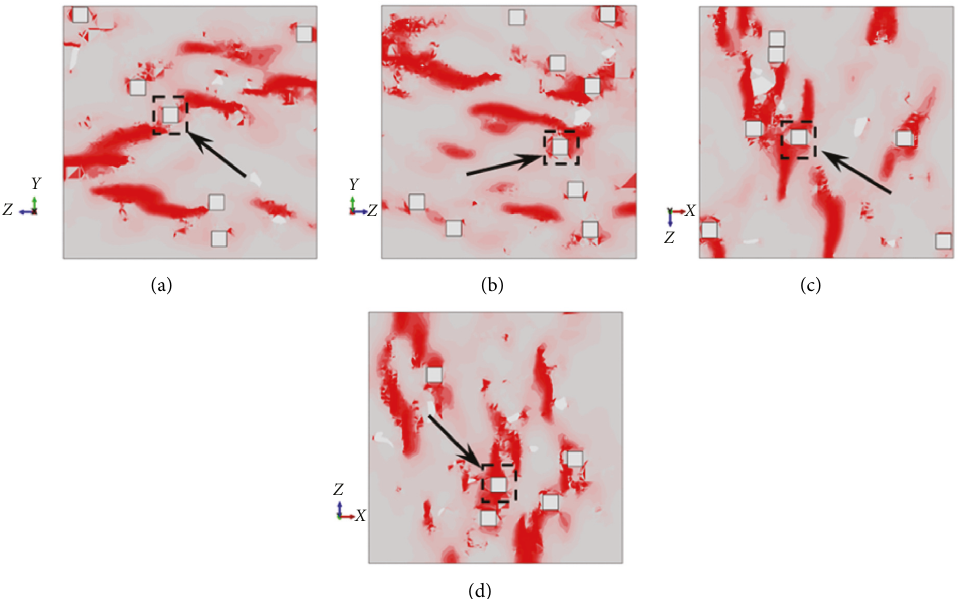
Figure 7: Tensile damage strip of concrete and selected rubber. (a) Front view, (b) back view, (c) left side view, (d) right side